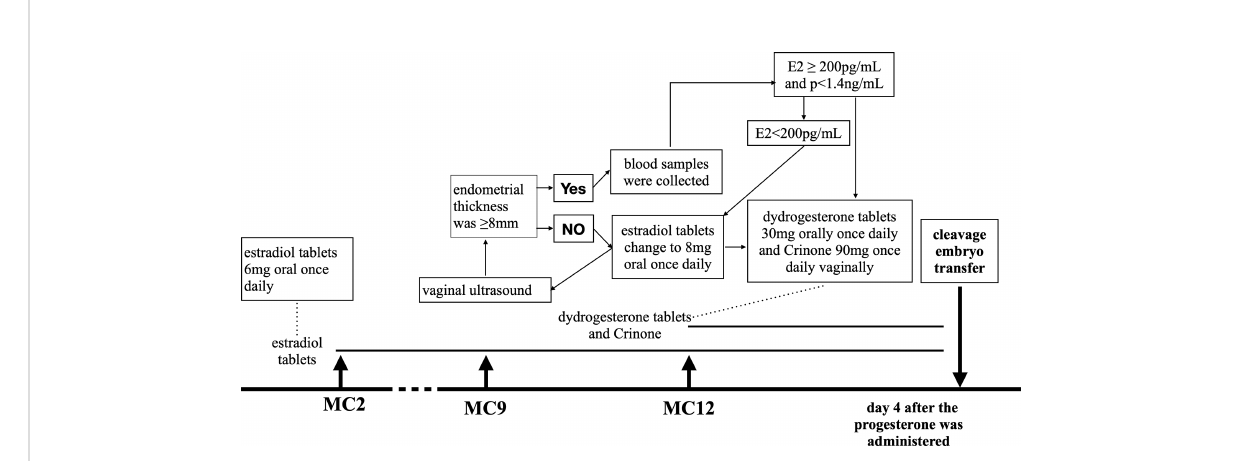
FIGURE 2 HRT protocol. MC, menstrual